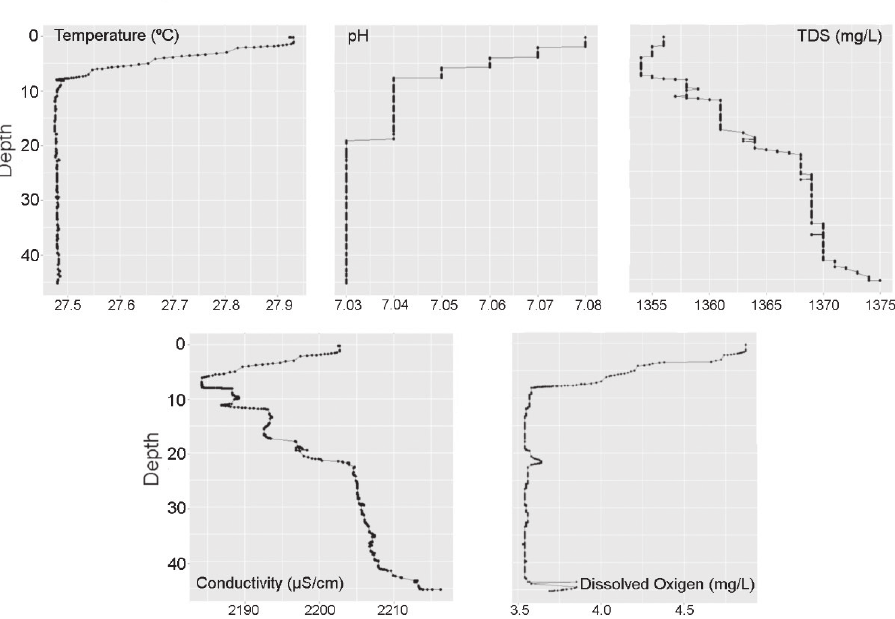
Figure 6. Water column environmental profiling of Cenote X-Batún: temperature, pH, total dissolved solids (TDS), conductivity and dissolved oxygen. Profiles are based on 350 measurements; black dots represent measured